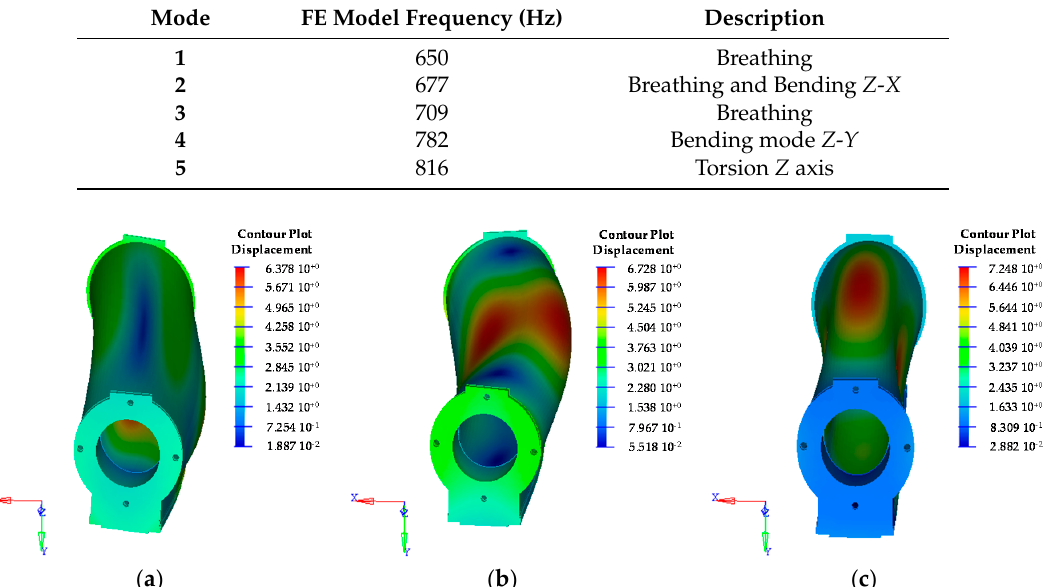
Table 6. Numerical modes and frequencies of the AFS ram.